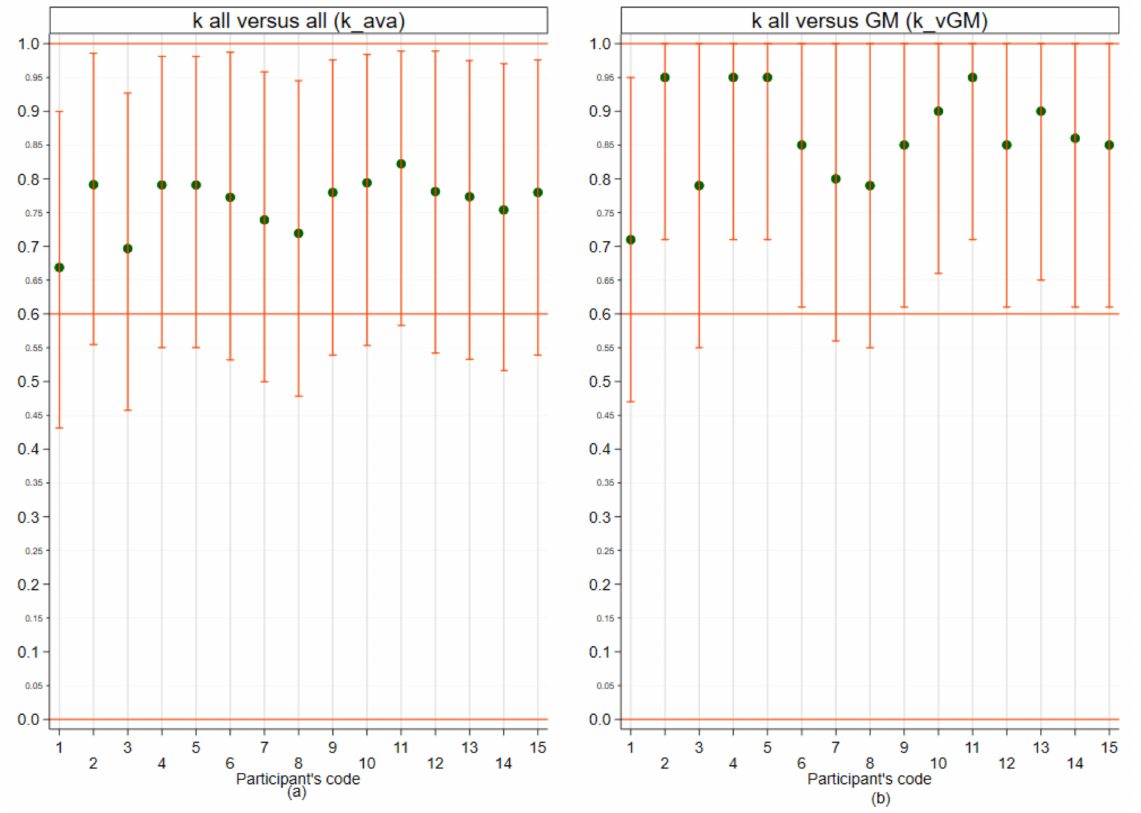
Figure 2. Performances of the panellists for outcomes expressed in terms of Hyperplasia- Dysplasia/Benign/Malignant (H, B, M). ( a ) mean k of each panellist versus all (k_ava); ( b ) mean k of each panellist versus GM (k_vGM). The points (green) represent the mean of Cohen’s k for each panellist; the vertical bars (orange) represent the 95% confidence interval. The horizontal line (red) represents the value above which the agreement is considered